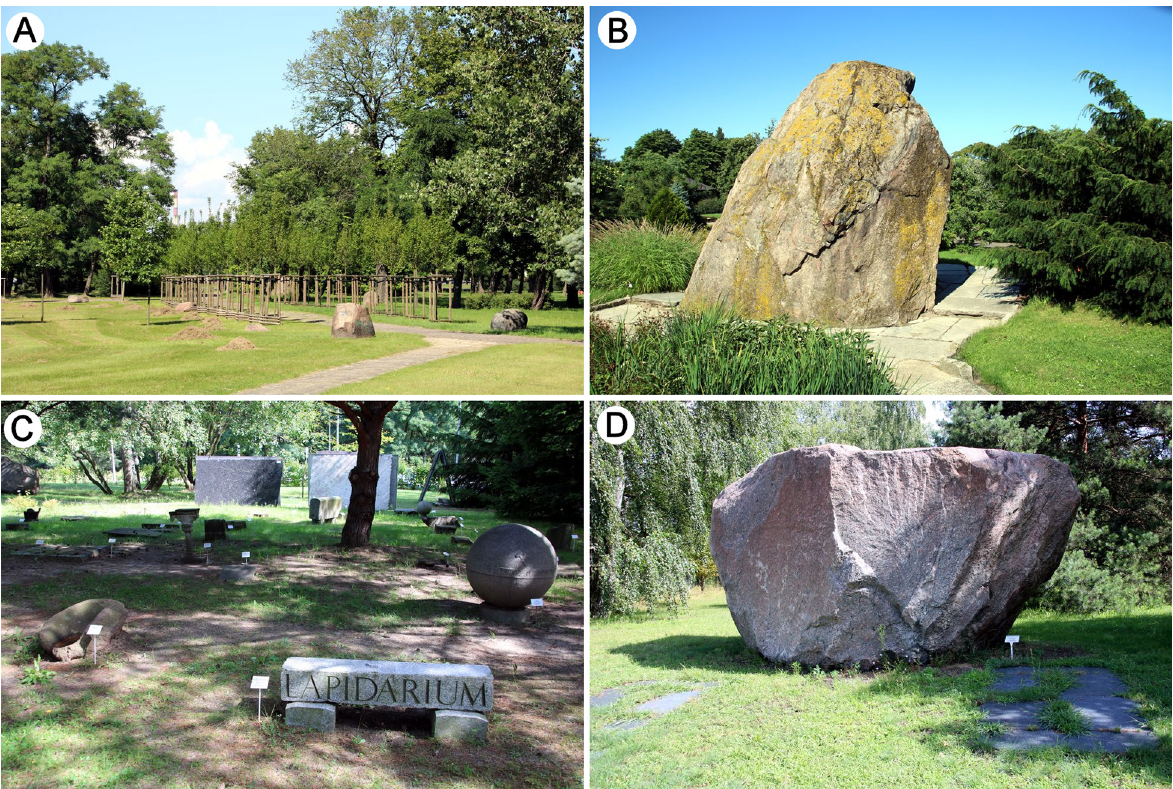
Fig. 5. Urban geosites of postglacial erratics in Poznań (Photo: M. Mazurek, July 2017). A – collection of erratics in Millenium Park, B – the biggest erratic (gneiss) in Poznań, Botanical Garden of the Adam Mickiewicz University in Poznań, C – lapidarium of the Institute of Geology of the Adam Mickiewicz University in Poznań, d – indicator erratic (karlshamn granite) in front of the Institute of Geology of the Adam Mickiewicz Uni- versity in